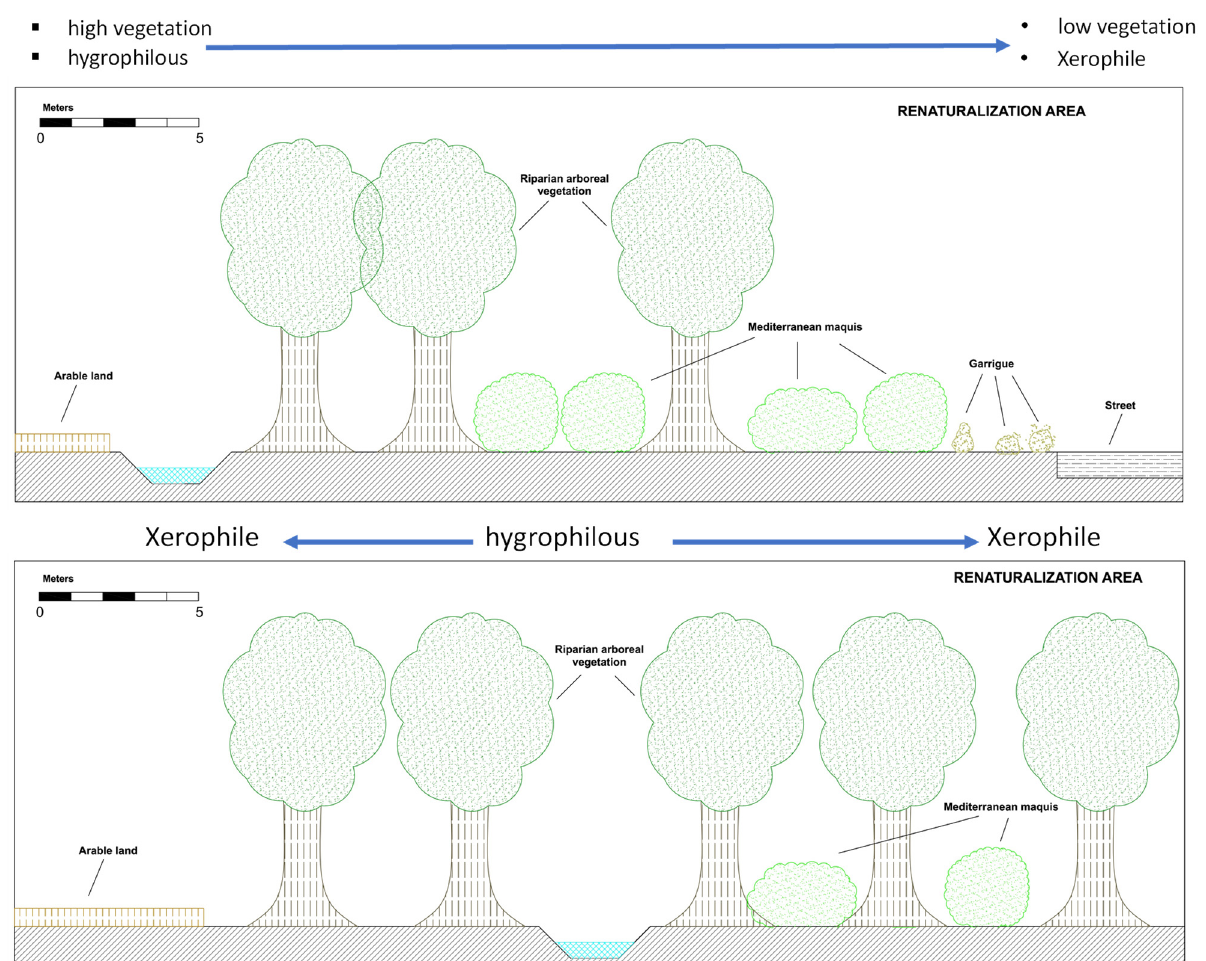
Figure 7. Cross-sections of the plant structure adopted for the ecological restoration along the channel.